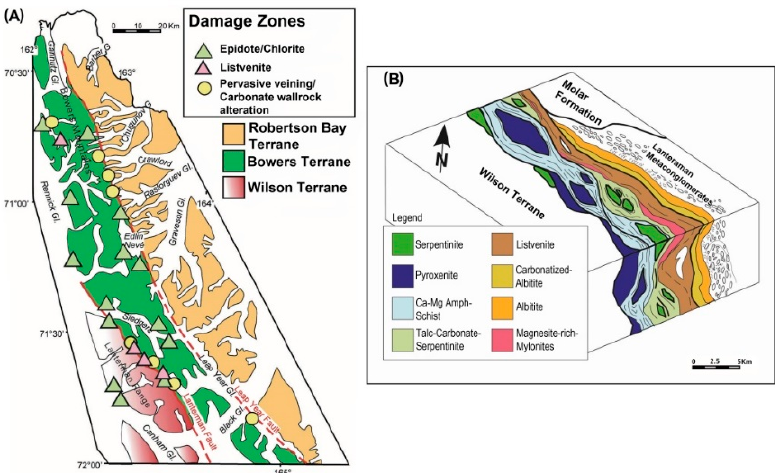
Figure 2. ( A ) Sketch map with the location of the fault (damage) zones where the hydrothermal alteration and veining is more intense (modified from [51]). ( B ) Sketch map of lithological- mineralogical sequences in the damage (fault) zone at the boundary of WT and BT (modified from [44]).